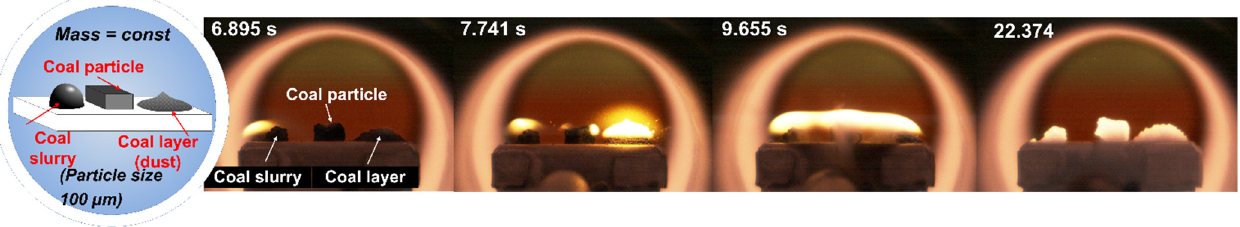
Figure 4. Video frame of the fuel combustion under identical conditions of feeding the fuel to the combustion chamber at 800 ° С